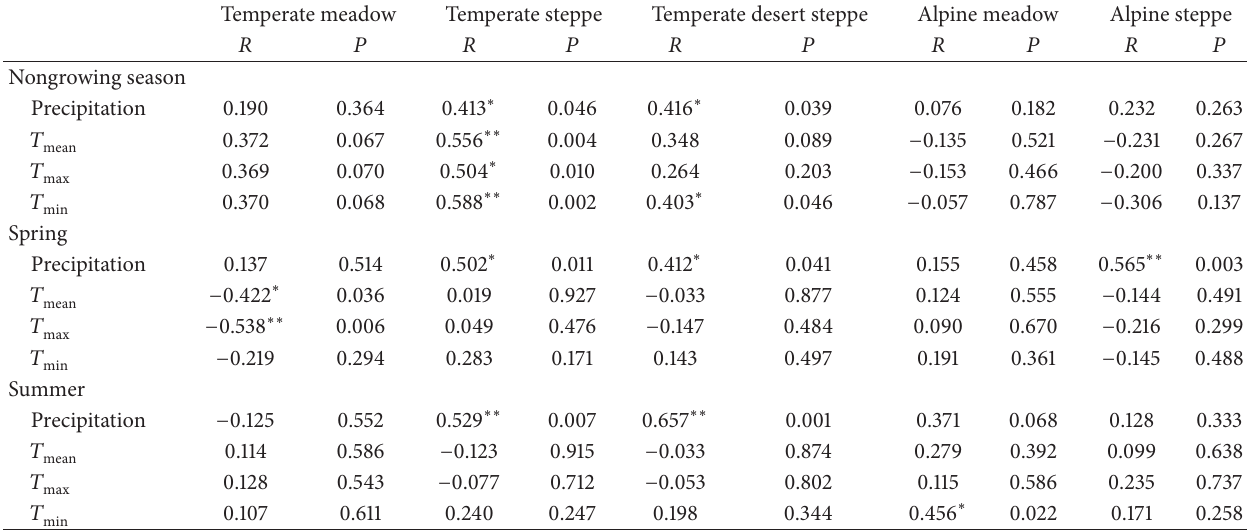
Table 3: Correlation coefficients ( 𝑅 ) and two-tailed significance test values ( 𝑃 ) between seasonal mean NDVI and precipitation or temperature in the previous season for different grassland